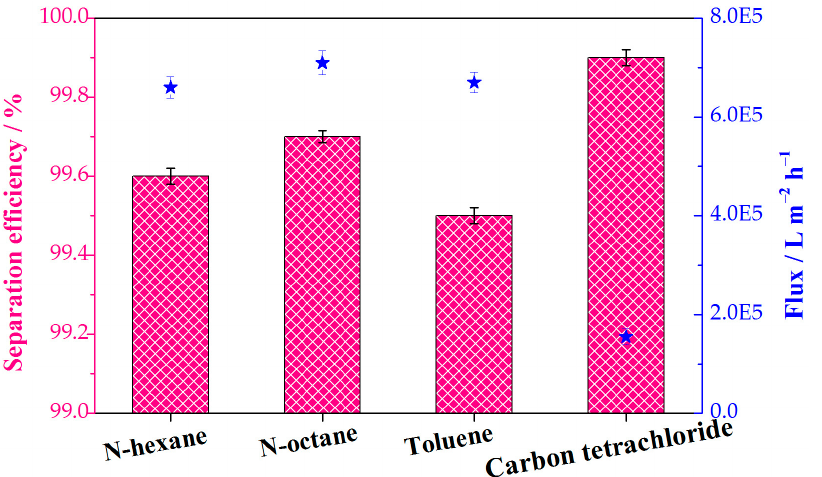
Figure 9. The separation efficiency and flux of various immiscible oil − water mixtures in the continuous separation process. The pink columns and blue stars represent the separation efficiency and flux, respectively.